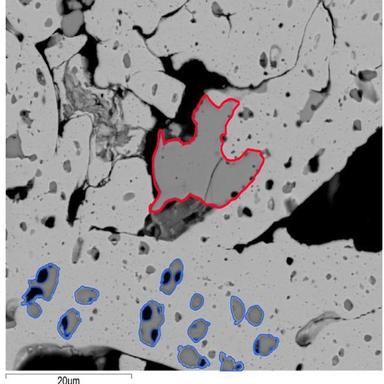
BSE image showing an americium e lanthanide e noble metal precipitate outlined in red in the mid-radius of the fuel and zirconium rich fuel phases outlined in blue, region 3 in (For interpretation of the references to color in this figure legend, the reader is referred to the Web version of this article.)